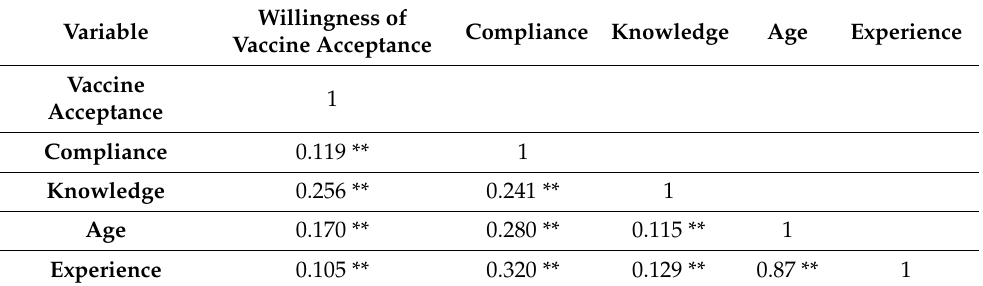
Table 3. Pearson’s correlation between knowledge of COVID-19, compliance of infection control precautions, age, years of experience, and willingness of acceptance of COVID-19